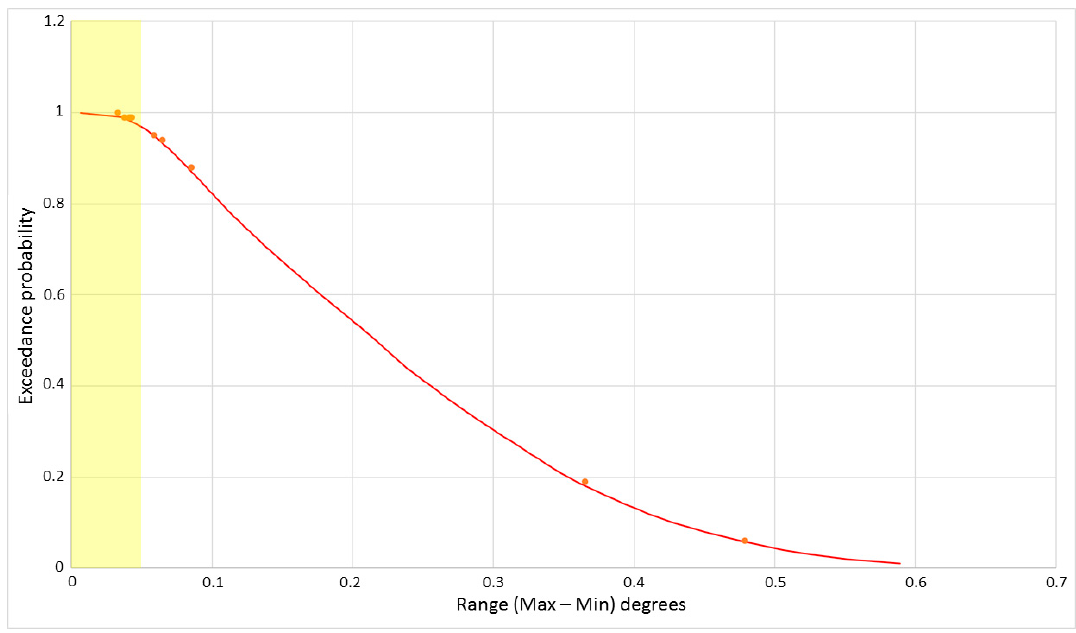
Figure 9. Sample error range exceedance probability plot for Group B pitch time series.